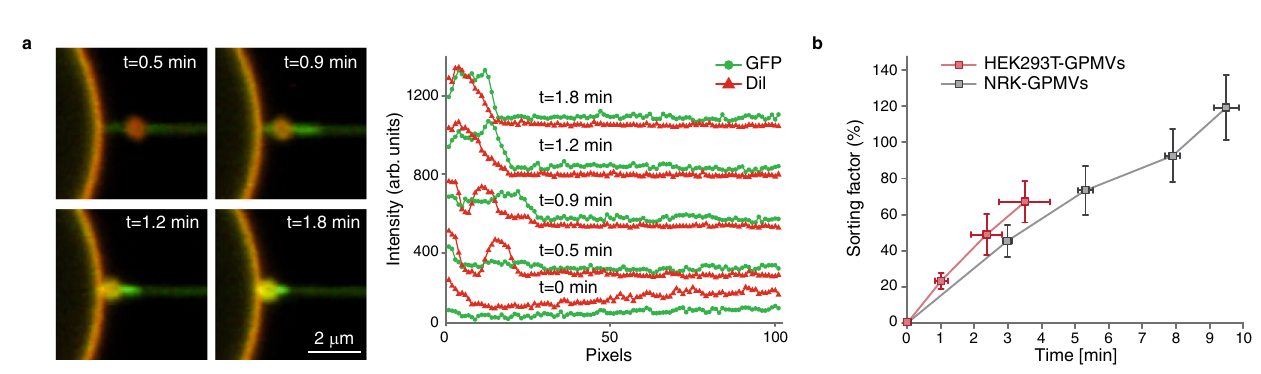
Fig. 3 | Swelling formation on a membrane tube induced by rapid tension increase.a Confocal microscopy images of a membrane tube pulledfrom a GPMV containing TSPAN4-GFP (green) and DiI-C12 (red)aspirated with a micropipette. In thetopimage,thesuctionpressurewaszero(correspondstozerotensionapplied, σ =0). Next, the tension increased immediately to 0.07mN/m. On the right side, schematic representation of tension-induced swelling formation assay.